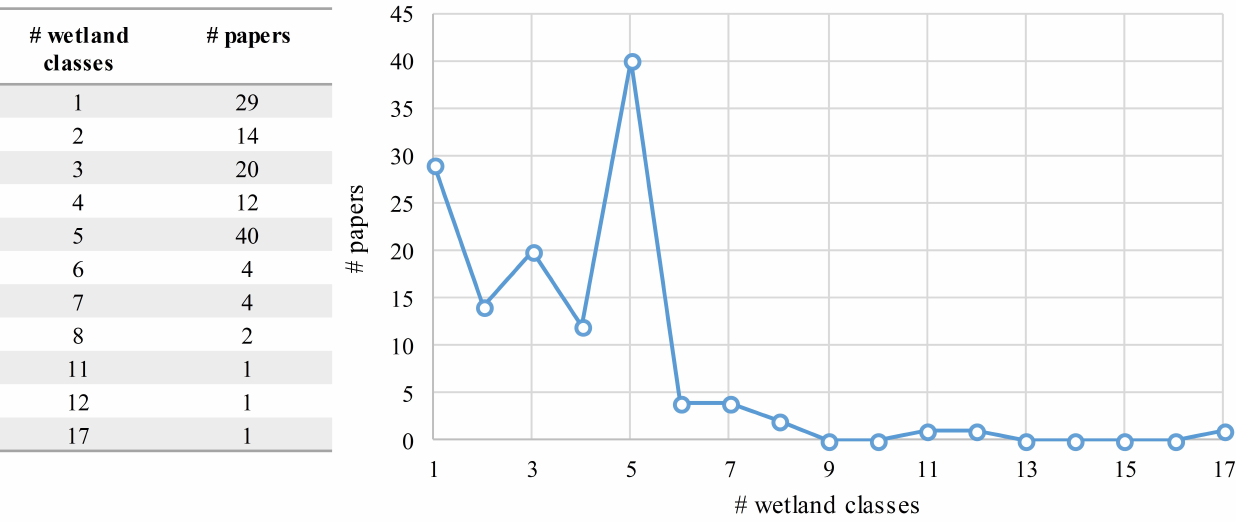
Figure 8. The number of papers based on the number of wetland classes